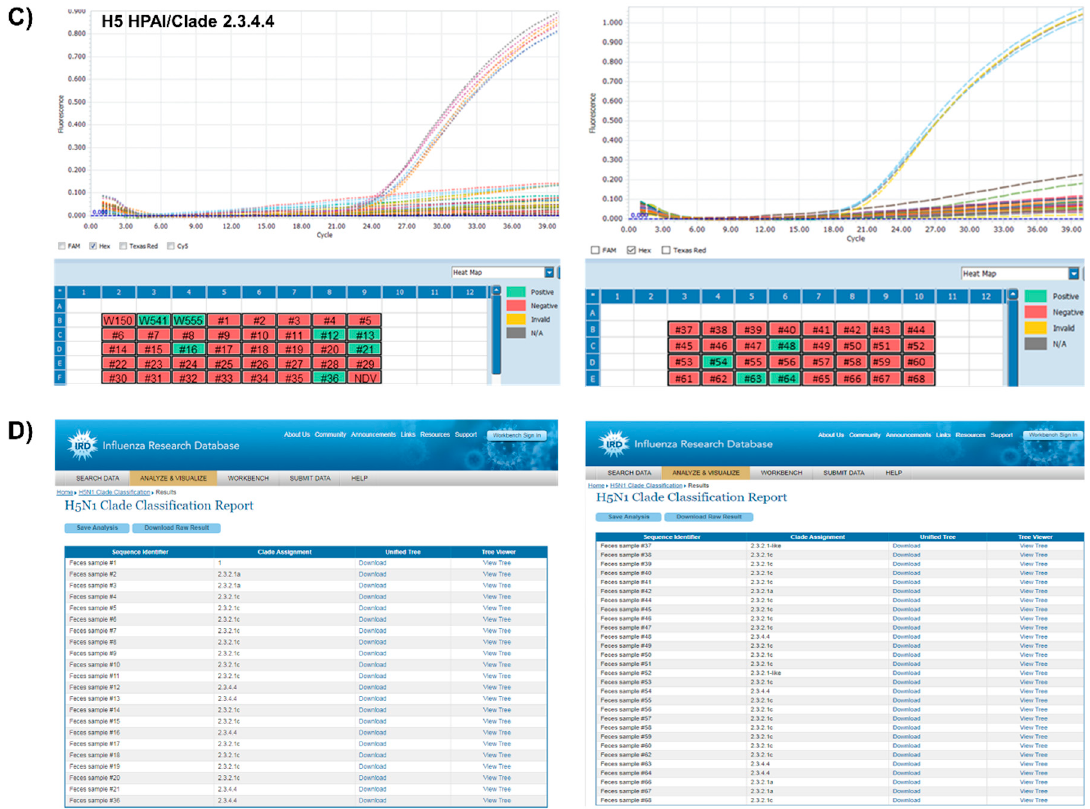
Figure 3. The one-step multiplex RT-qPCR assay for the detection of pan-H5 HPAI ( A ), H5 HPAI 2.3.2.1 clade ( B ), and H5 HPAI 2.3.4.4 clade ( C ) in field-infected feces samples. The validity of this assay was confirmed using M-gene positive field samples, H5Nx HPAI viruses for positive control, and Newcastle Disease virus for negative control. The results were visualized using an intuitive heat-map (green color-positive result, red color-negative result). Each concentration had triple replicates. ( D ) Clade classification of HPAI H5 subtype viruses from field-infected feces samples. The HA1 partial sequences of the HA gene with multiple basic cleavage sites were obtained by conventional RT-PCR and all H5 HPAI-positive sequences were verified using the Influenza Research Database (www.fludb.org).